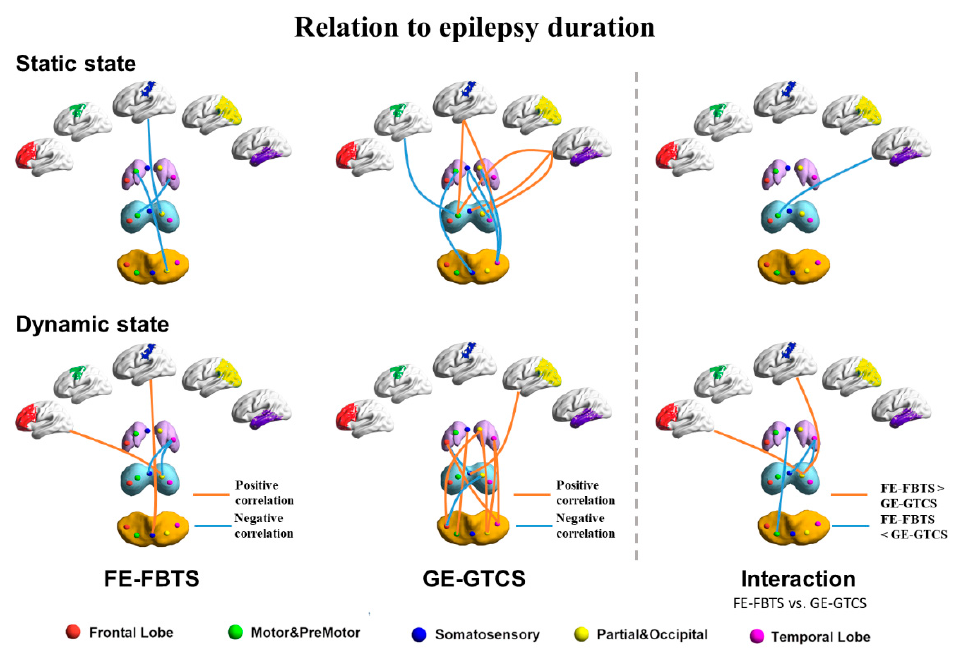
Figure 3. The correlation between functional connectivity networks and duration in the group of GE-GTCS, FE-FBTCS, and a comparison between the two patient groups in the static state and dynamic state. Red: frontal lobe, Green: motor/premotor, Blue: somatosensory, Yellow: partial–occipital, Violet: temporal lobe. Purple: striatum, Light blue: thalamus, Orange: cerebellum.